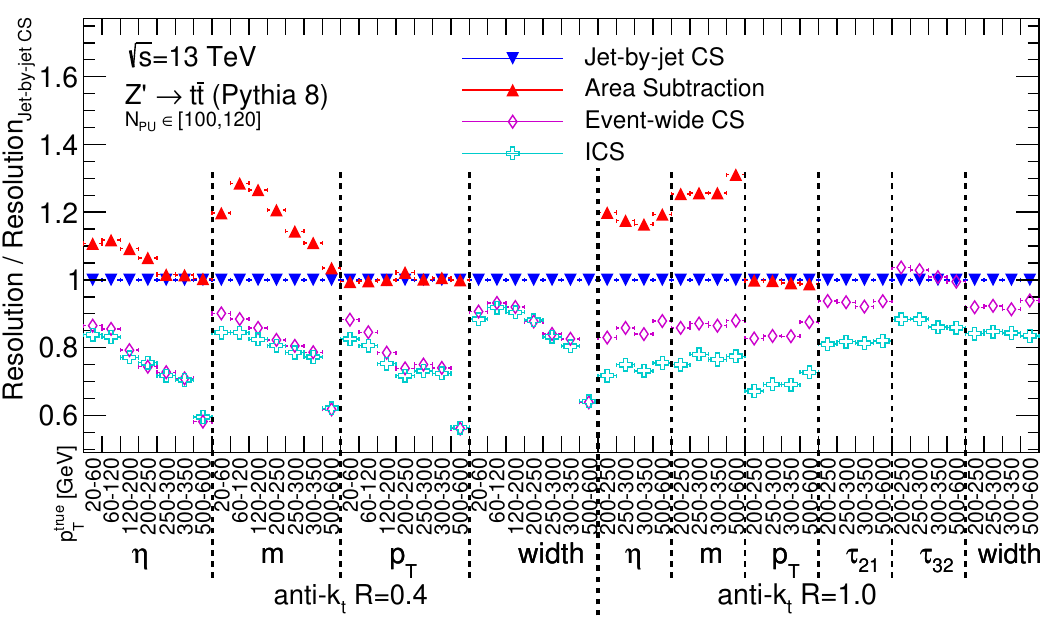
Figure 5. Performance of the pileup subtraction evaluated in terms of the ratio of resolution with respect to the resolution from Jet-by-jet CS algorithm for di(cid:11)erent observables: jet (cid:17) , mass, p T , width for R = 0 : 4 jets and jet (cid:17) , mass, p T , width, (cid:28) 21 , (cid:28) 23 for R = 1 : 0 jets. Each bin on the x -axis represents a given range of true jet p true de(cid:12)ned by the bin-label. Bins on the x -axis are T grouped to distinguish observables and jet radii. Four algorithms are compared: Jet-by-jet CS, Area Subtraction, Event-wide CS, and ICS